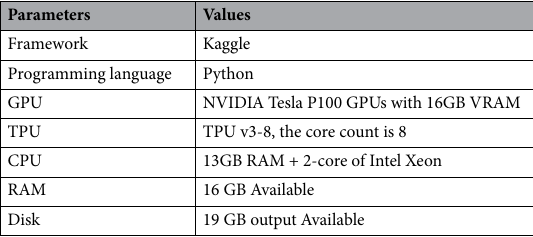
Table 3. Computing